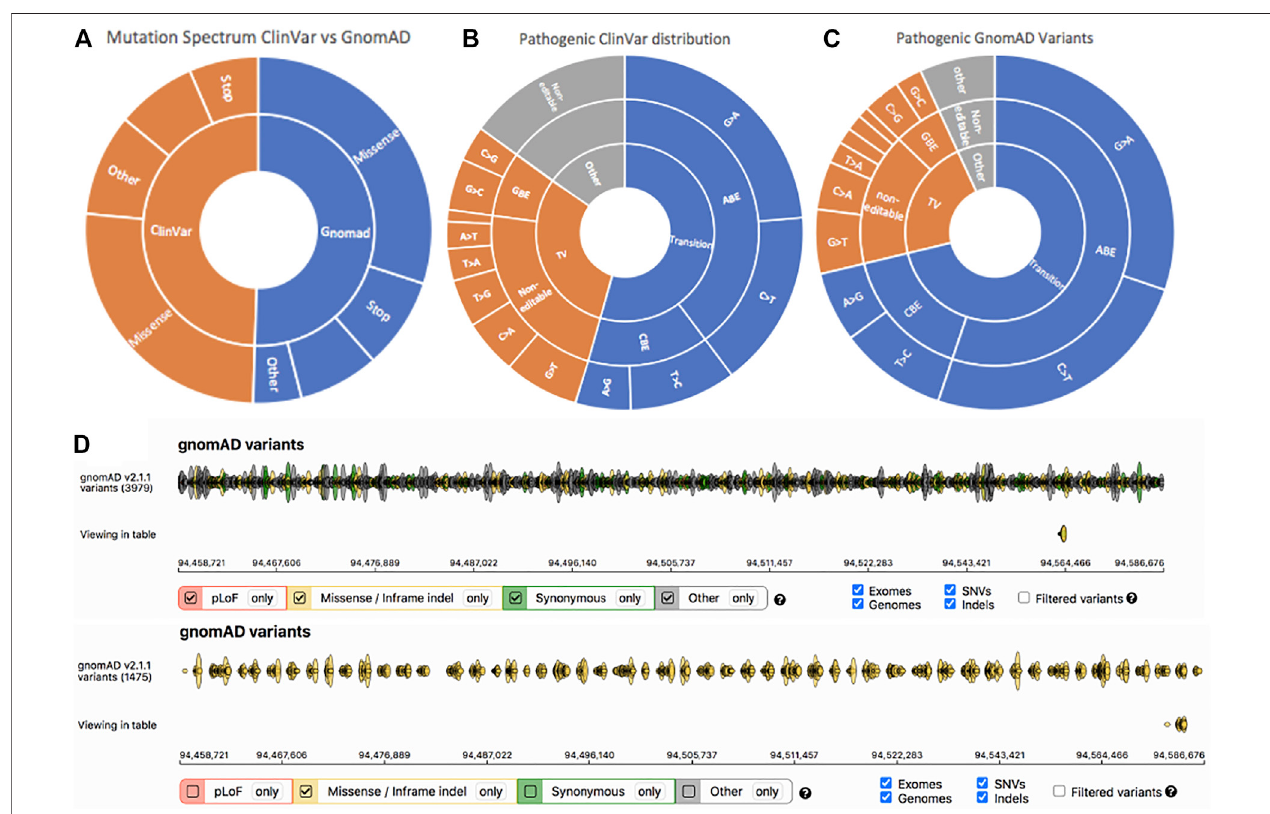
FIGURE 3 | A) Charts showing distribution of mutation classi fi cation and type in both ClinVar and gnomAD. Missense mutations were the most prevalent overall in both ClinVar and gnomAD. making up 63% of mutations. Pathogenic mutations were then characterised for both ClinVar (B) and gnomAD (C) data sets. Transition mutations made up a larger percentage of “ pathogenic ” and “ likely pathogenic ” mutations in gnomAD (71%) than in ClinVar (54%). However, when looking at the complete data set of each, transition mutations made up 62% of the gnomAD database and 59% of the ClinVar database. (D) A heatmap taken from gnomAD showing all gnomAD variants (top) and all missense variants